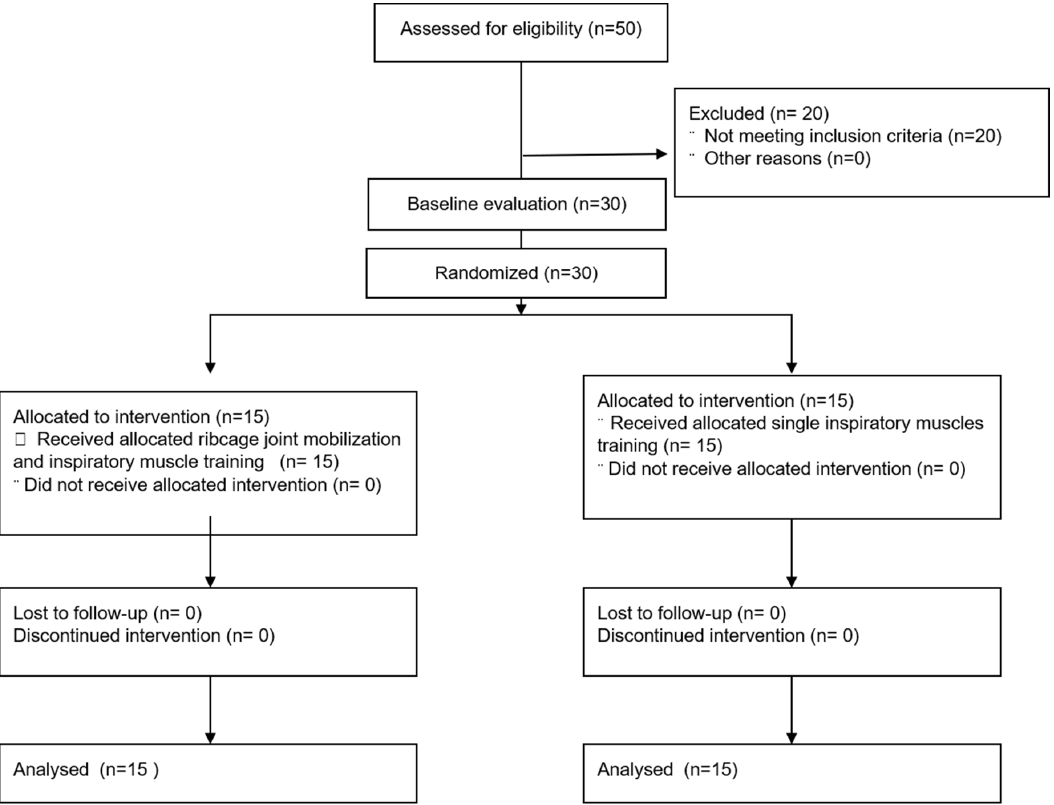
Figure 1. Flowchart of randomization.